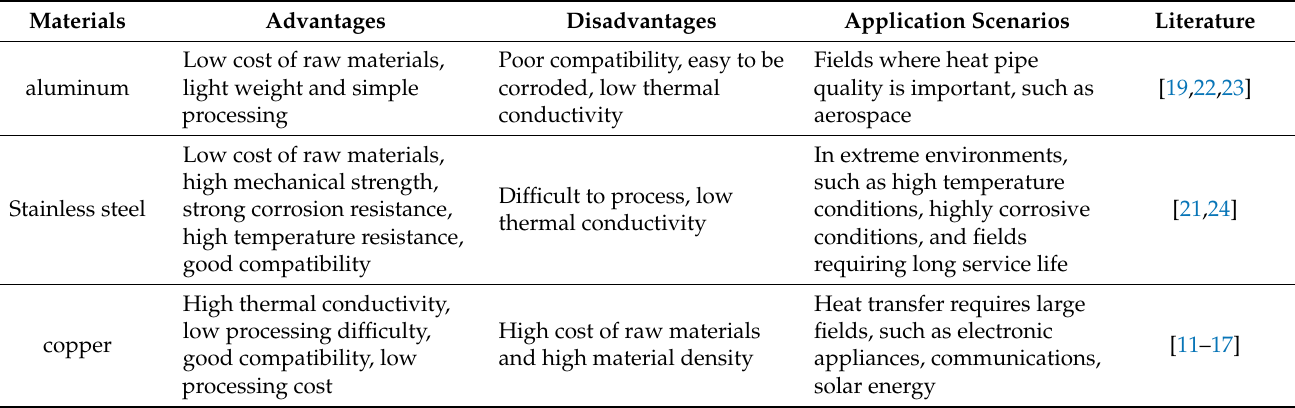
Table 1. Advantages and disadvantages of heat pipes with different shell materials and their application